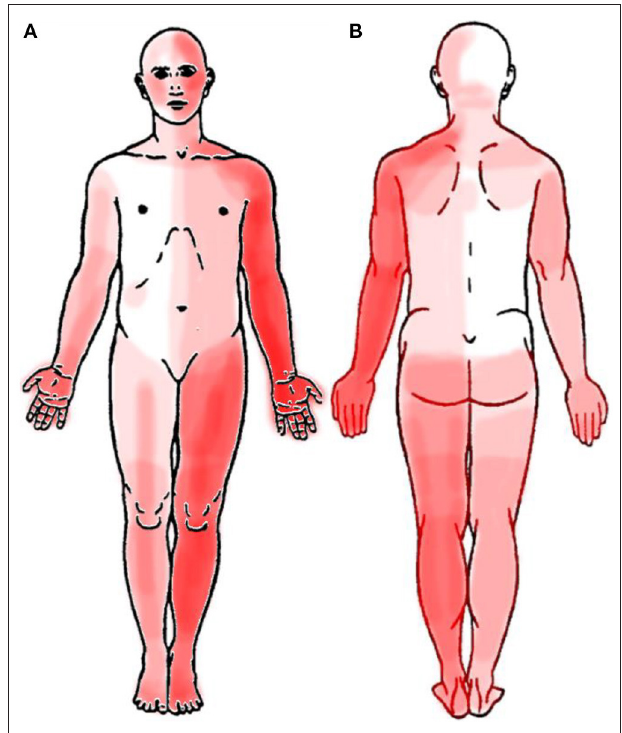
FIGURE 3 | Localization of sensory symptoms in front (A) and back (B) views in patients [frequency between 0 (white) and 15 (dark